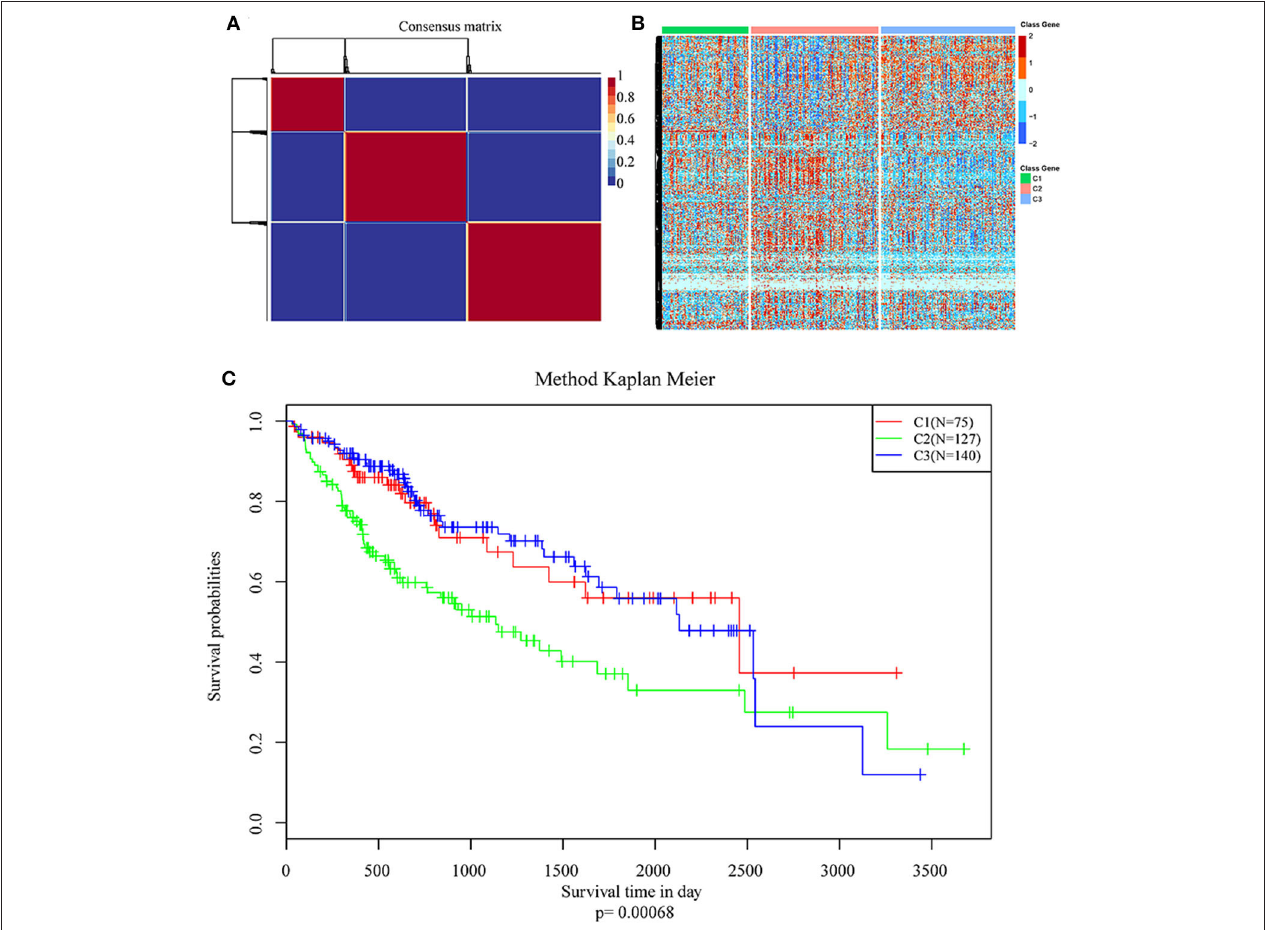
FIGURE 2 | Identification of molecular subtypes of hepatocellular carcinoma (HCC) using TCGA data associated with prognosis. (A) The non-negative matrix factorization (NMF) consensus matrix plot for 594 metabolism-related genes identified three distinct HCC subtypes: C1, C2, and C3. (B) Heatmap of the expression of genes related to energy metabolism in three molecular subtypes; (C) Kaplan–Meier (KM) curves of overall survival (OS) in the three molecular subtypes.